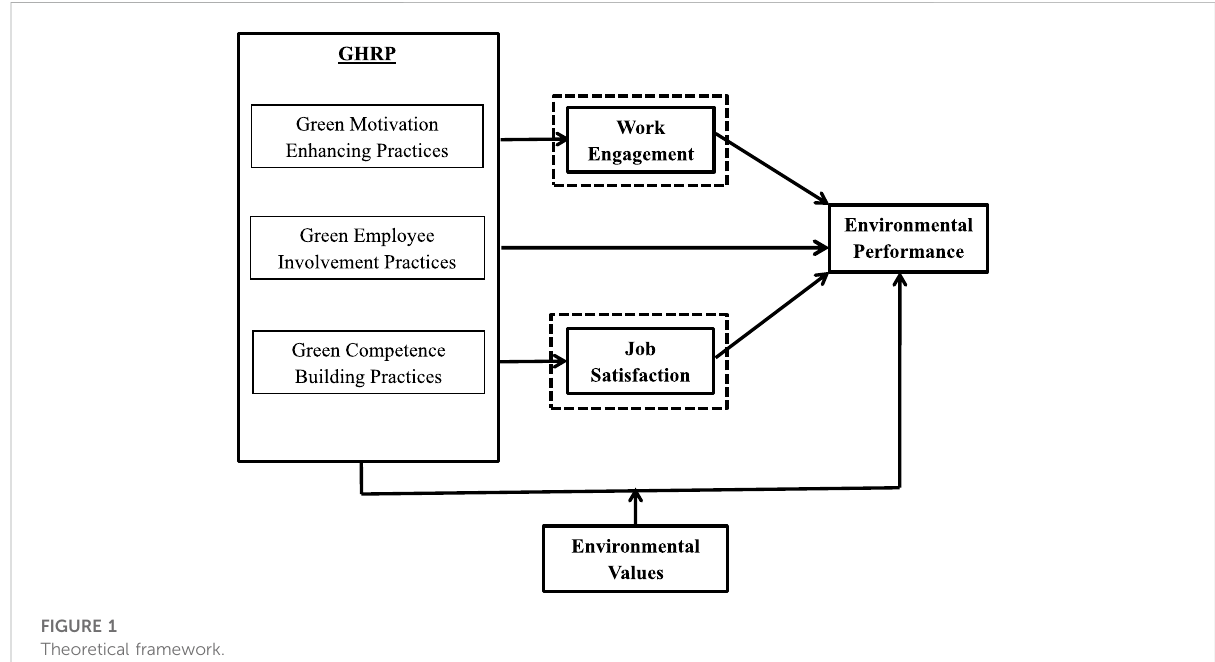
FIGURE 1 Theoretical